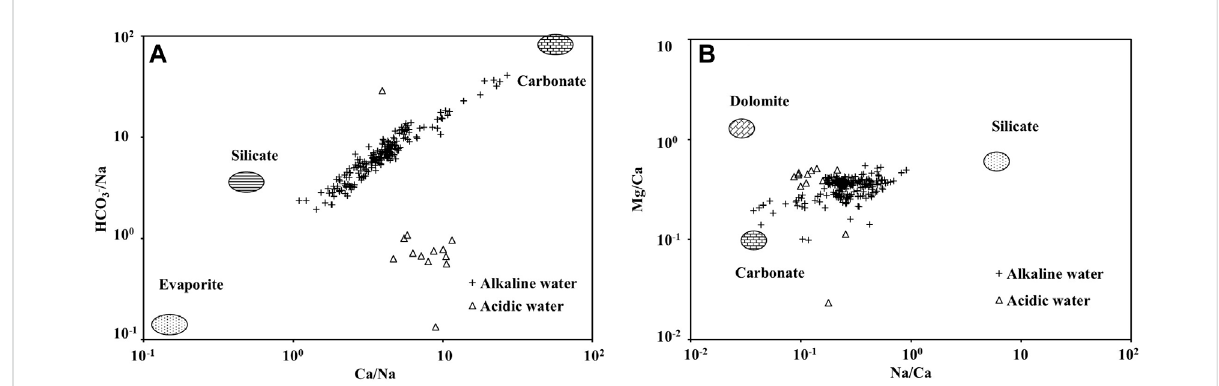
FIGURE 4 Identi fi cation of chemical sources in the Chetian River based on (A) HCO 3 − /Na + versus Ca 2+ /Na + and (B) Mg 2+ /Ca 2+ versus Na + /Ca 2+